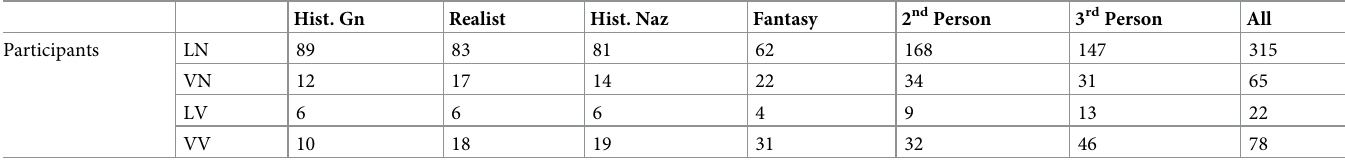
Table 5. Choice path distribution by genre and perspective (N = 480). Hist. Gn